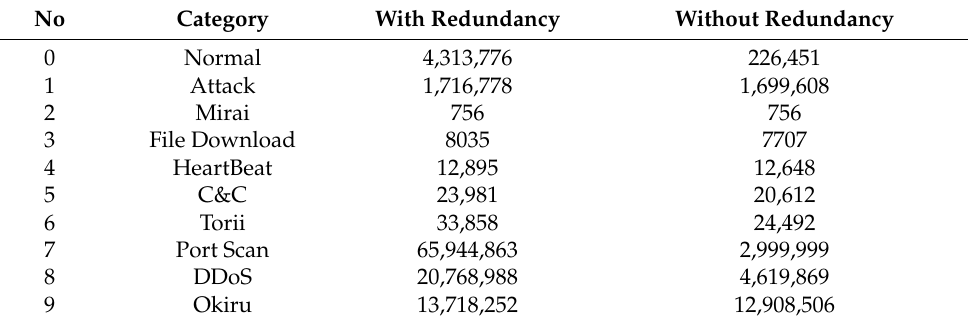
Table 5. IoT-23 dataset instances.